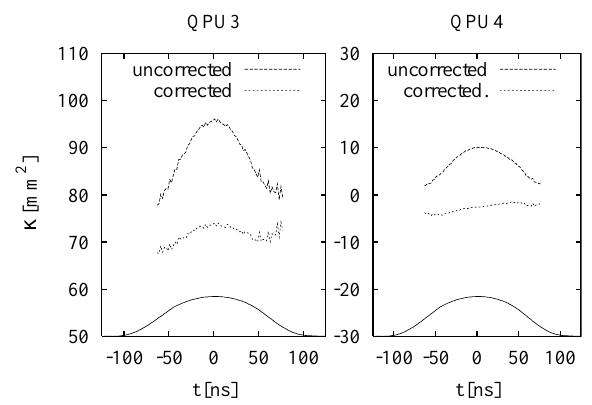
FIG. 10. Quadrupole moment as a function of position within the bunch, with and without correction for dispersive contribu- tion. The bunch shape is also indicated (solid